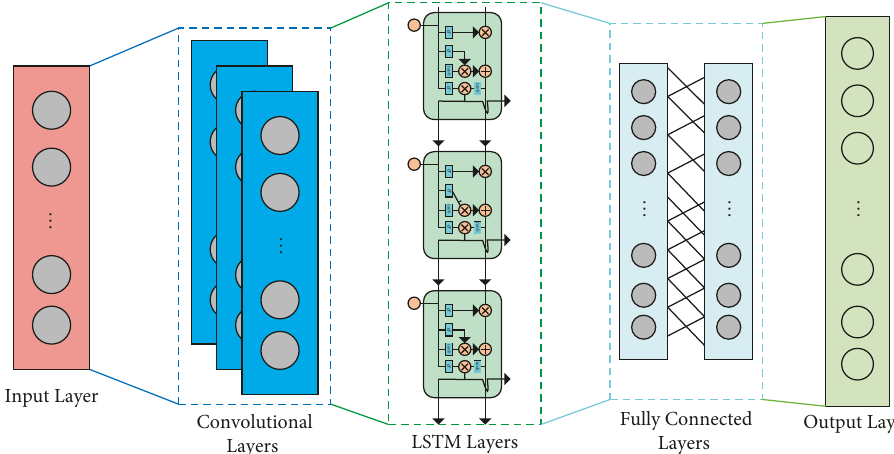
Figure 7: Architecture of CNN-LSTM CF